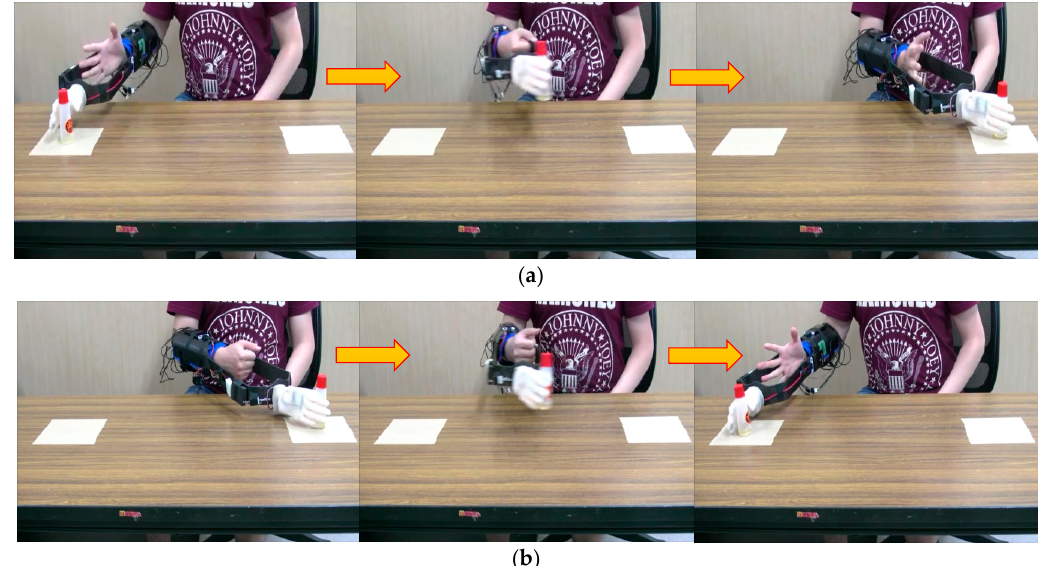
Figure 21. Pick-and-place task: ( a ) one successful pick-and-place task (from left move to right); ( b ) one successful pick-and-place task (from right move to left). Table 7. Experimental objects.